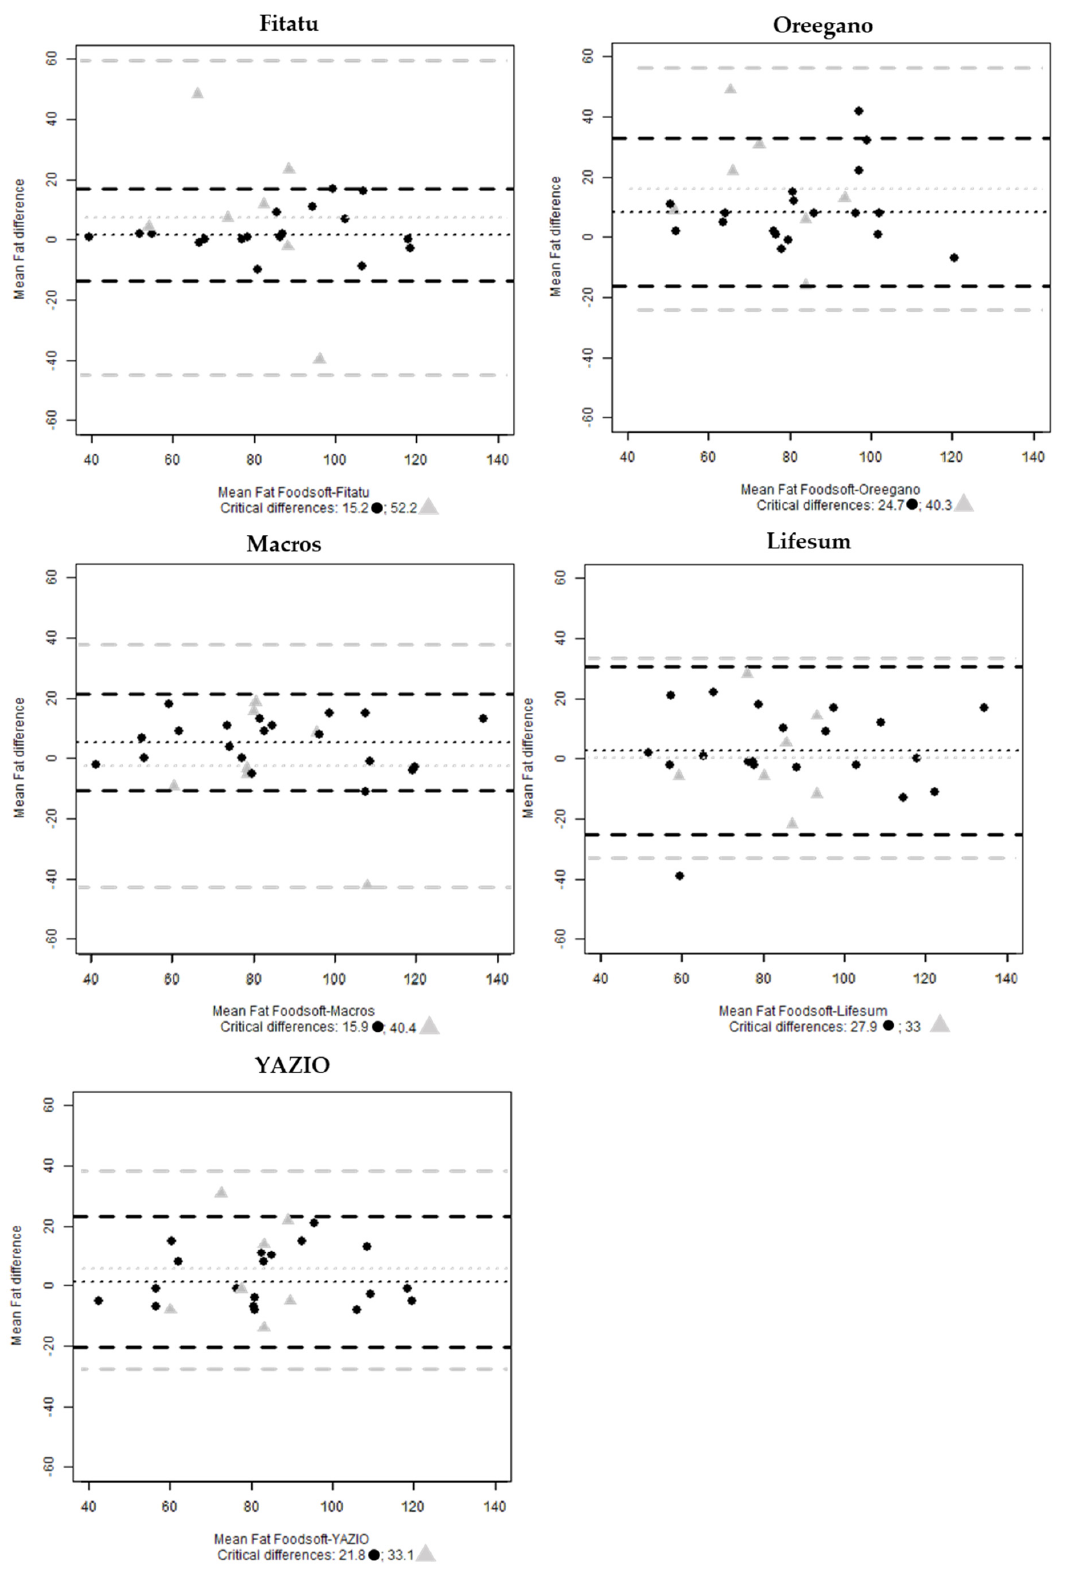
Figure 6. Bland-Altman plots of mean fats (g) difference between Foodsoft 1.0 and Fitatu, Oreegano, Macros, YAZIO and Lifesum whole sample ( ● ) and the selected 24-HRs ( ).